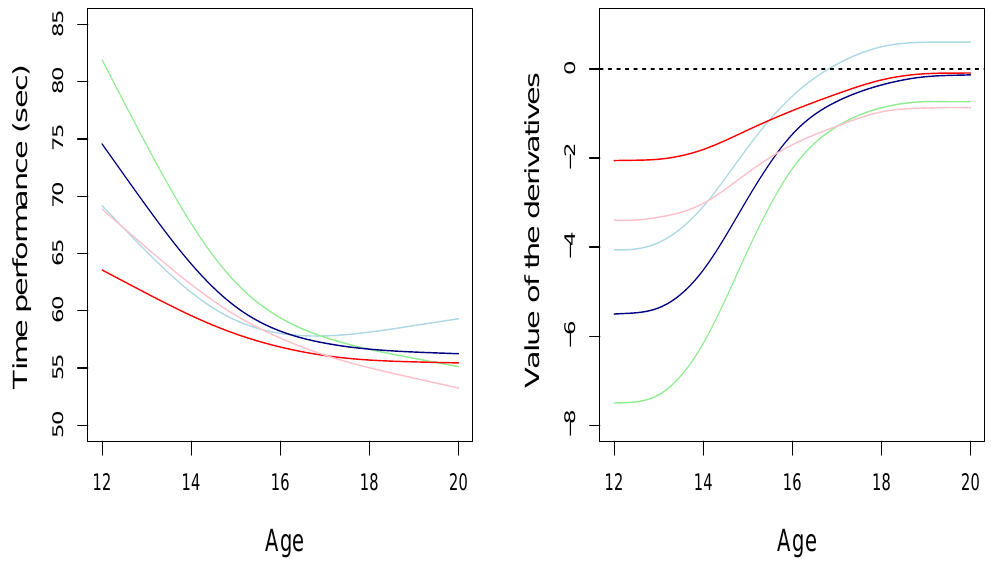
Figure 6. Cluster centres’ curves of swimmers ( left ) and derivatives ( right ) coloured by clusters, obtained with the multivariate clustering funHDDC algorithm. Similar information as in Figure 4 can be seen on this graph, in a clearer way with only the centre of clusters